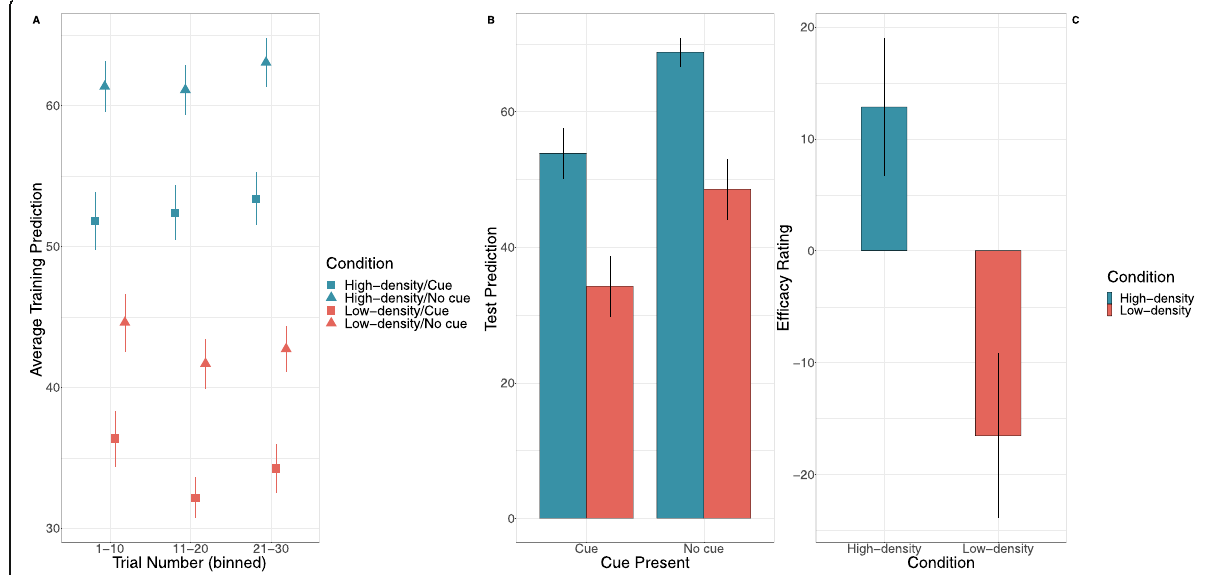
Fig. 8 Results from Experiment 4 for a training predictions as a function of outcome density condition, cue presence, and trial as well as b predictions of students ’ average performance as a function of outcome density condition and c efficacy ratings as a function of outcome density condition. Error bars represent + 1 standard error of the